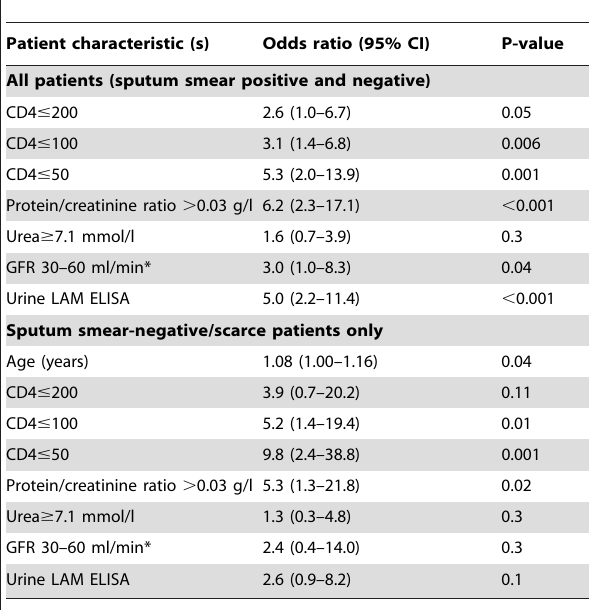
Table 3. Associates of MTB/RIF positivity in HIV-infected m.tb culture positive patients stratified by smear